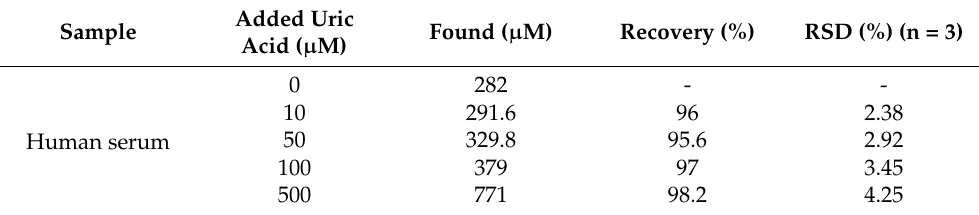
Table 2. Uric acid detection in human serum with cobalt oxide/GCE sensor.